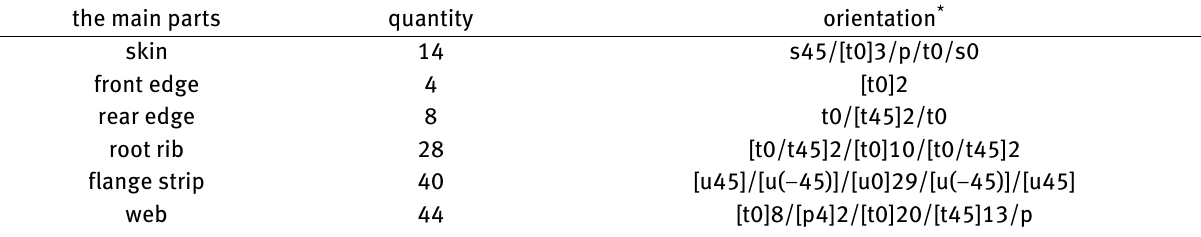
Table 2: Layout of wing main structure the main parts